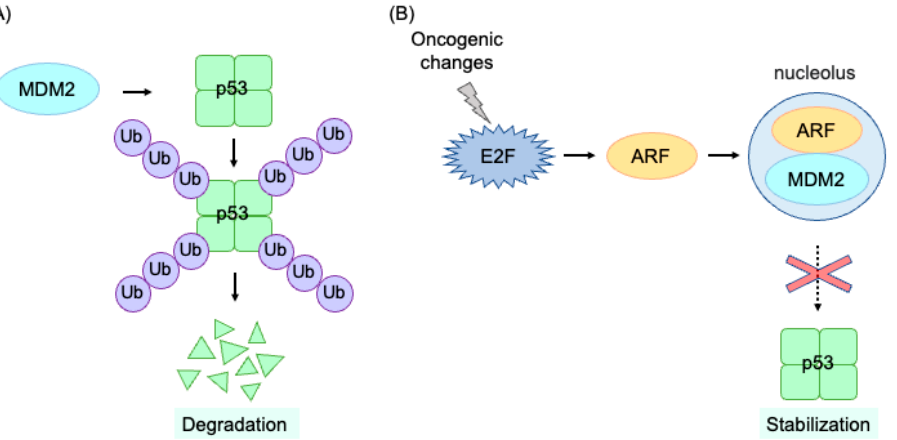
Figure 4. Regulatory mechanism of p53 activity by protein degradation and stabilization. ( A ) In normal cells, the level of p53 protein is kept low by MDM2-mediated ubiquitination and proteasome-mediated degradation. ( B ) Upon oncogenic changes, E2F is activated independently of pRB control (deregulated E2F) and induces expression of the tumor suppressor gene ARF . ARF binds to and translocates MDM2 into the nucleolus, thereby preventing MDM2-mediated ubiquitination and degradation and stabilizing p53 protein.